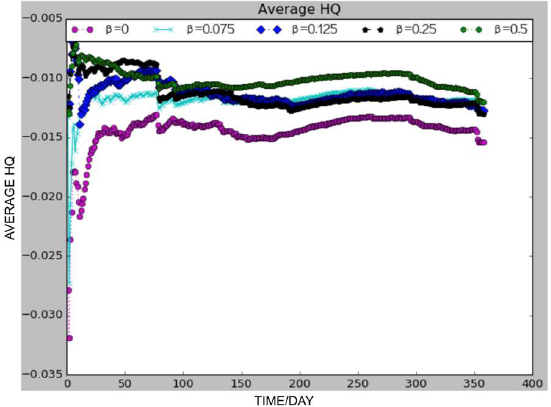
( a ) 100 days’ average HQ of optimized evolutionary using different 𝛽 . Figure 13. One hundred days’ and 150 days’ average HQ of optimized evolutionary using different 𝛽 in Shanghai dataset.